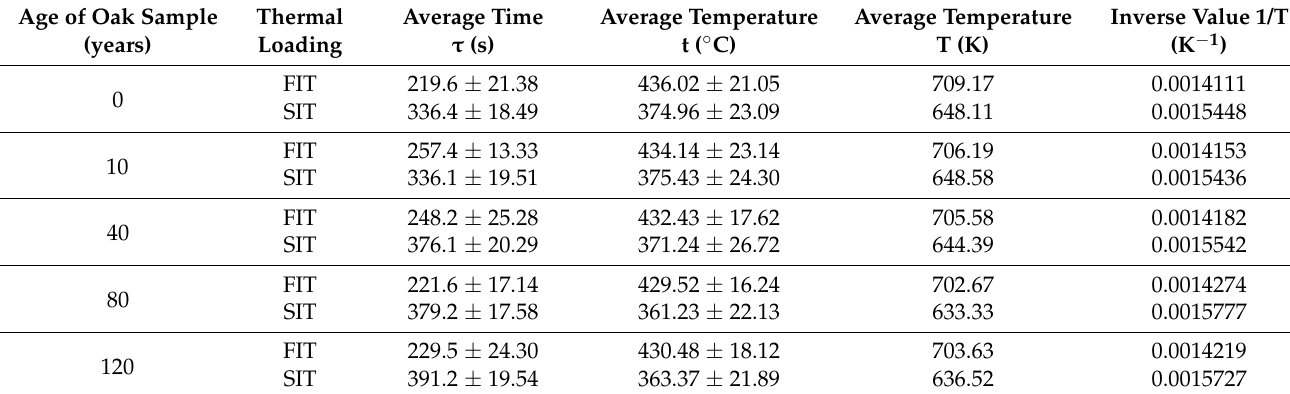
Table 4. Flame ignition temperature and spontaneous ignition temperature of oak wood samples. Age of Oak Sample